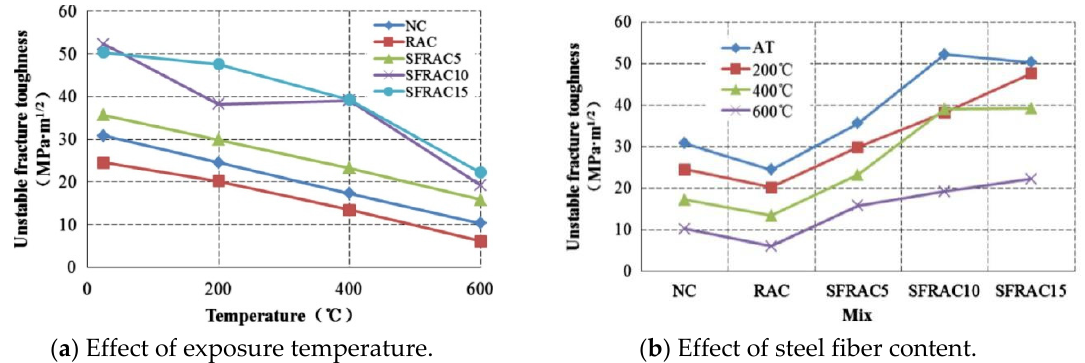
Figure 7. Effects of exposure temperature and steel fiber content on initiation fracture toughness [13].